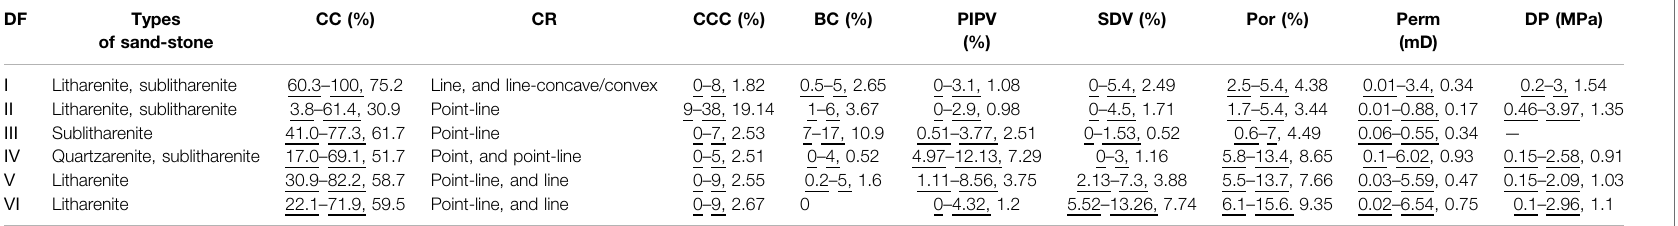
TABLE 2 | Diagenetic facies types and characteristics of kepingtage